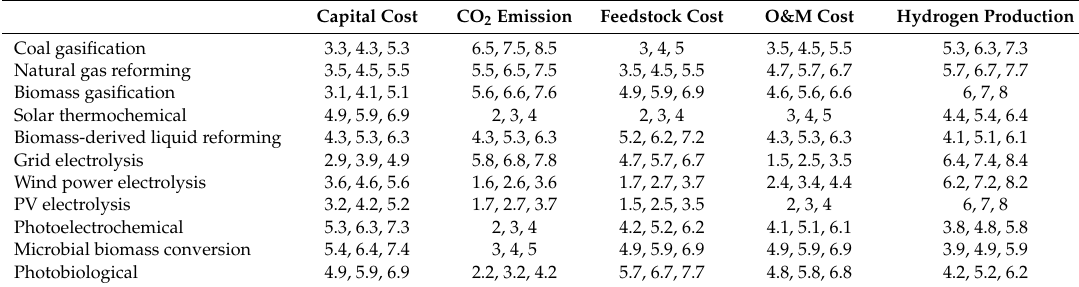
Table 6. Fuzzy decision matrix of criteria.